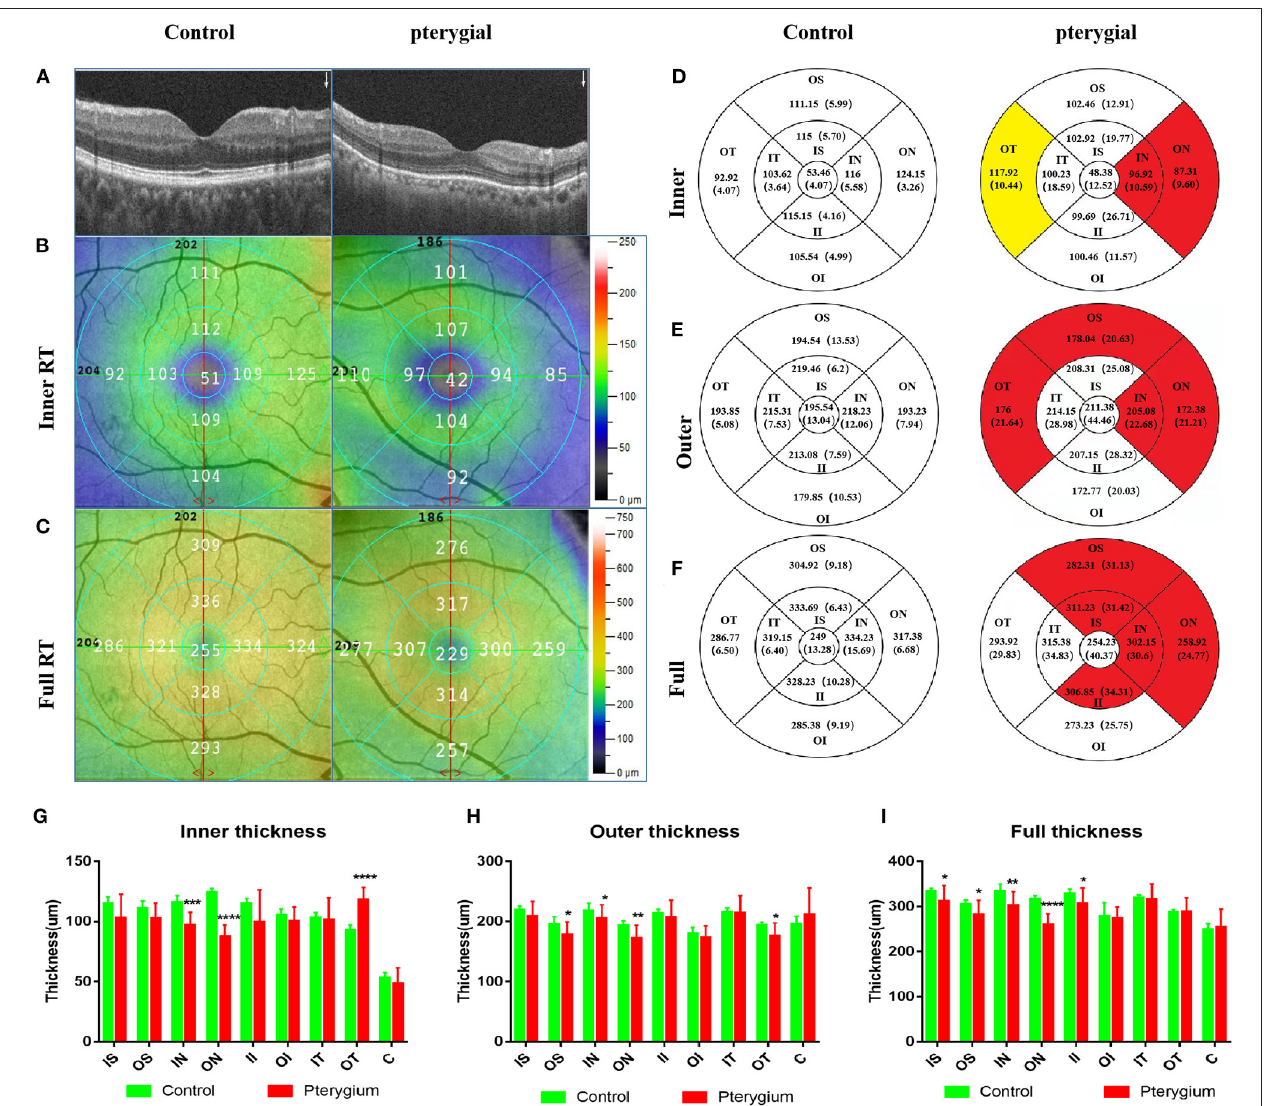
FIGURE 3 | OCTA images and RT analysis of the control group and pterygium group. (A) RT cross sections of the control group and pterygium group measured by OCTA. (B) Internal RT was measured with ETDRS. (C) Complete RT measurement diagram. (D) Internal RT measurement results of the control group and pterygium group (red area indicates the area with significant decrease in retinal thickness, yellow area indicates the area with significant increase in retinal thickness, P < 0.05). (E) External RT measurements in the control group and pterygium group (F) complete RT measurements. (G–I) Analysis of retinal thickness results in the control group and pterygium group. OCTA, optical coherence tomography angiography; RT, retinal thickness; ETDRS, early treatment of diabetic retinopathy study; IS, inner superior; OS, outer superior; IN, inner nasal; ON, outer nasal; II, inner inferior; OI, outer inferior; IT, inner temporal; OT, outer temporal; C, center. * P < 0.05; ** P < 0.01; *** P < 0.001; **** P <